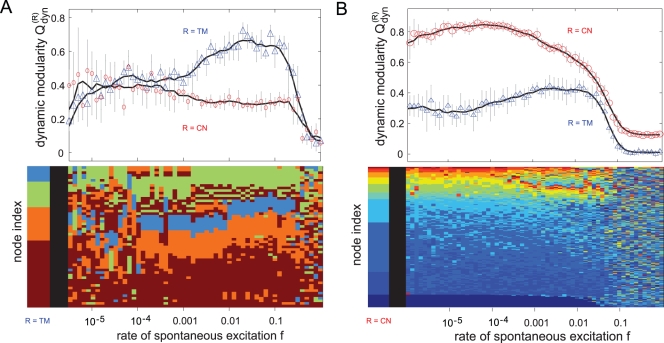
Levels of dynamic organization in two different neuronal networks.The highlighted curves (bigger symbols; top row) correspond to the respective DDC vector results (bottom row). (A) The dominance of modular elements in the cortical network of the cat is reflected by a distinct increase of Qdyn for the TM-dependent results in the high-f regime (blue ▵; top) as well as by the homogeneous clustering of the DDC vectors (TM-dependent results; bottom), while central node effects seem to play only a marginal role (see the slight superelevation in the low-f regime [red ○]; top). (B) By contrast, the cellular network of C. elegans displays a strong dependency on two adjoining central nodes which dominate the dynamics in a wide range of f. The drastic increase of the CN-dependent results for Qdyn in the low-f region (red ○; top) reflects the high order of the DDC vectors (CN-dependent results; bottom) with a conserved distance ranking of the topologically detected node clusters. Even here, there exists a noticeable but comparatively subordinate influence of the module-based excitation patterns (blue ▵; top).